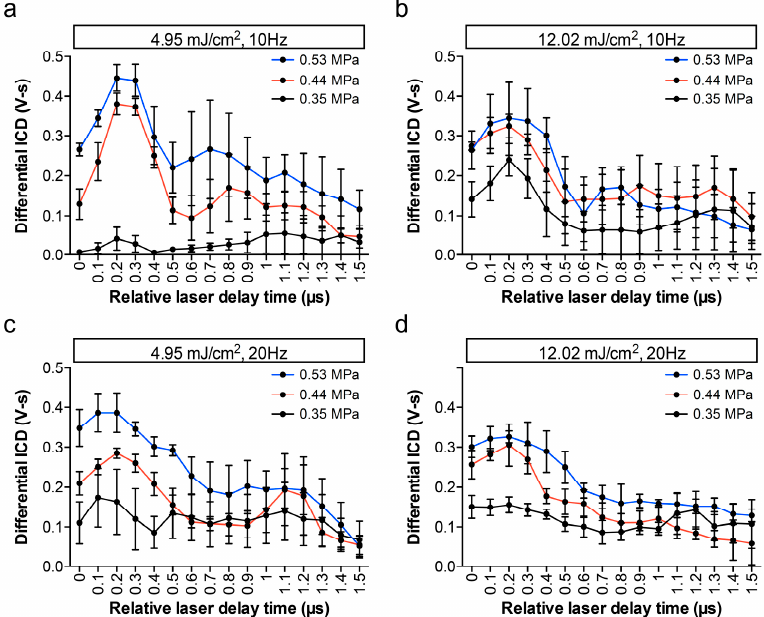
Figure 6. AuNDs cavitation triggered using ultrasound and laser simultaneously. The di ff erential inertial cavitation dose (ICD) values were plotted as a function of relative laser delay time. In each individual experiment, 200 recordings were collected at ( a ) 4.95 mJ / cm 2 , 10 Hz, ( b ) 12.02 mJ / cm 2 , 10 Hz, ( c ) 4.95 mJ / cm 2 , 20 Hz and ( d ) 12.02 mJ / cm 2 , 10 Hz. Lines labeled in di ff erent colors denote di ff erent driving acoustic PNPs in each figure. Each point indicates the mean and SD for three individual experiments.